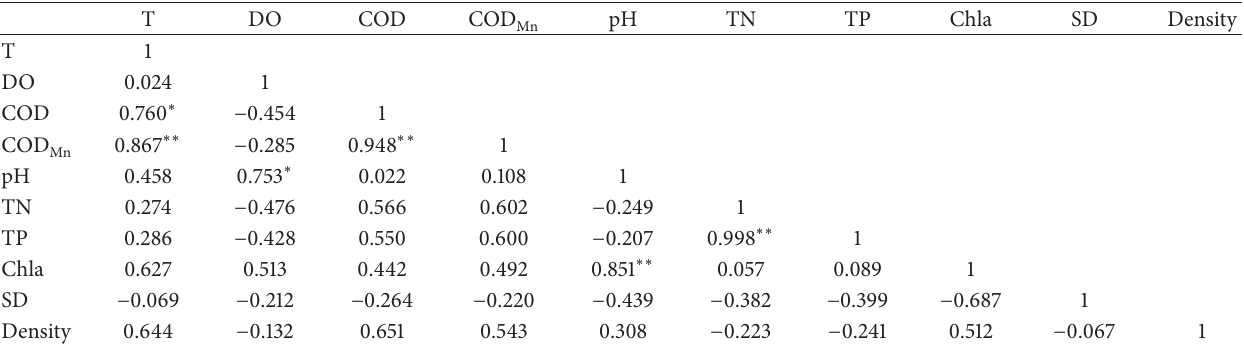
Table 2: Correlation analysis between phytoplankton density and environmental factors of Baiyangdian Lake in